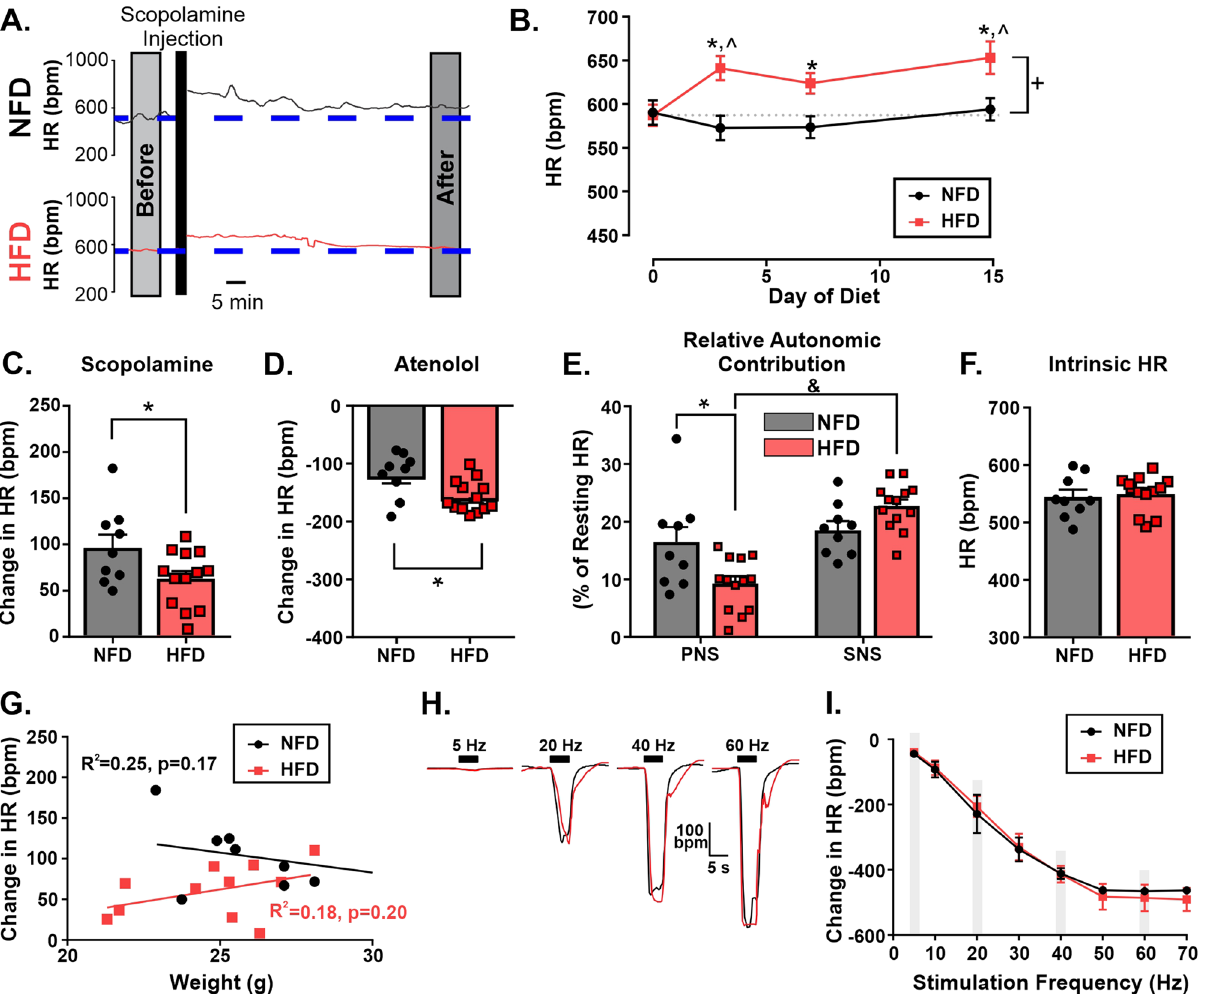
Figure 2. HFD induced a resting tachycardia and depressed vagal contribution to HR. These cardiovascular changes are centrally mediated. Representative HR trace from awake mice on Day 15 of diet before and after administration of methylscopolamine ( A ). Quiet resting HR was significantly increased after HFD (n = 15) compared to NFD (n = 13) ( B ). HFD (n = 13) reduced HR responses to methylscopolamine ( C ) and increased HR responses to atenolol ( D ) compared to NFD (n = 9). Change in HR after autonomic blockade as a percentage of initial resting HR change in HR demonstrated a significant reduction in parasympathetic tone, but not sympathetic tone ( E ). Intrinsic HR was not different between HFD (n = 13) and NFD (n = 9) ( F ). Linear regression showed no correlation between change HR or weight for either group ( G ). Representative image of HR change to nerve stimulation ( H ). Frequency stimulation curves in vagotomized mice did not differ with diet (NFD: n = 5; HFD: n = 5; p = 0.96). ( I ). * denotes significant difference from NFD; ^ denotes significant difference from time 0; + denotes significant difference from NFD regardless of day; & denotes significant difference from PNS within HFD did not inhibit the response of HR to graded electrical stimulation of the vagus efferent fibers. To assess the extent to which the observed reduction in vagal HR control reflects dysfunction in central circuitry relative to a reduction in the chronotropic response to efferent vagal activity, HR responses to graded electrical stimulation of right vagus nerve efferent fibers were recorded in mice where the vagus nerves had been bilaterally transected. Electrical stimulation of the distal segment of the transected vagus nerve elicited a frequency dependent bradycardia in all mice examined (repeated measure mixed-effects model ANOVA; stimu- lation frequency; p < 0.0001; Fig. 2H-I). Regardless of diet, increasing frequency of electrical stimulation of vagal motor fibers induced graded bradycardia (5 Hz: 41.7 ± 5.1 bpm; 10 Hz: 89.9 ± 15.6 bpm; 20 Hz: 217.8 ± 31.9 bpm; 30 Hz: 334.3 ± 25.7 bpm; 40 Hz: 412.9 ± 14.3 bpm; 50 Hz: 472.6 ± 19.7 bpm; 60 Hz: 477.2 ± 22.0 bpm and 70 Hz: 478.9 ± 19.5 bpm). There was, however, no significant interaction between diet and stimulation frequency (NFD: n = 5; HFD: n = 5; p = 0.98) and no difference in the bradycardic responses between diets regardless of the fre- quency of stimulation (p = 0.96). Therefore, stimulation of the vagal motor fibers to activate intracardiac ganglia and influence vagal drive at the SA node remained unaffected after two weeks of HFD.